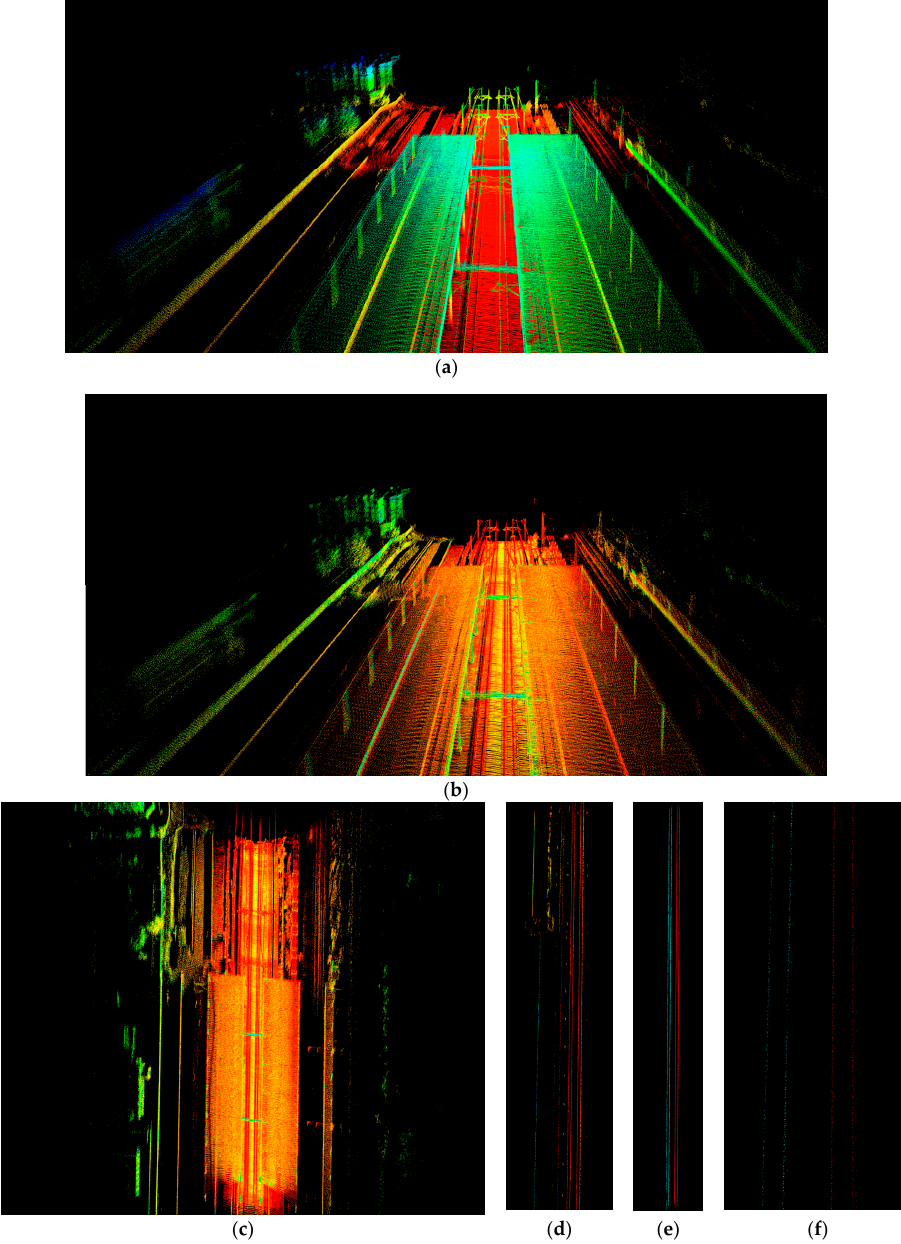
Figure 10. ( a ) Output map with weak/no GNSS signals, colored by elevation; ( b ) Output map with weak/no GNSS signals, colored by intensity; ( c ) Rail station, top view; ( d ) Raw rail extract results; ( e ) Final results; ( f ) Zoom in view of final results.